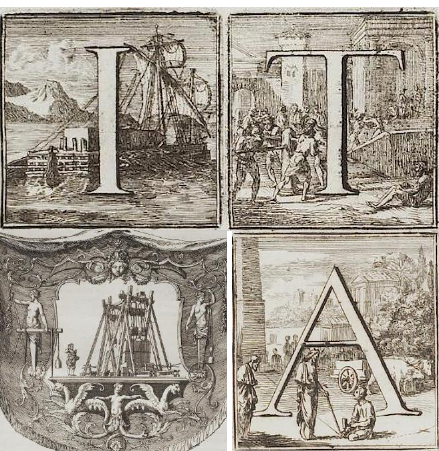
Figure 5: Transport of the obelisk by ship from Egypt, Onward transport, Installation in Rome, Marking of the midday line,